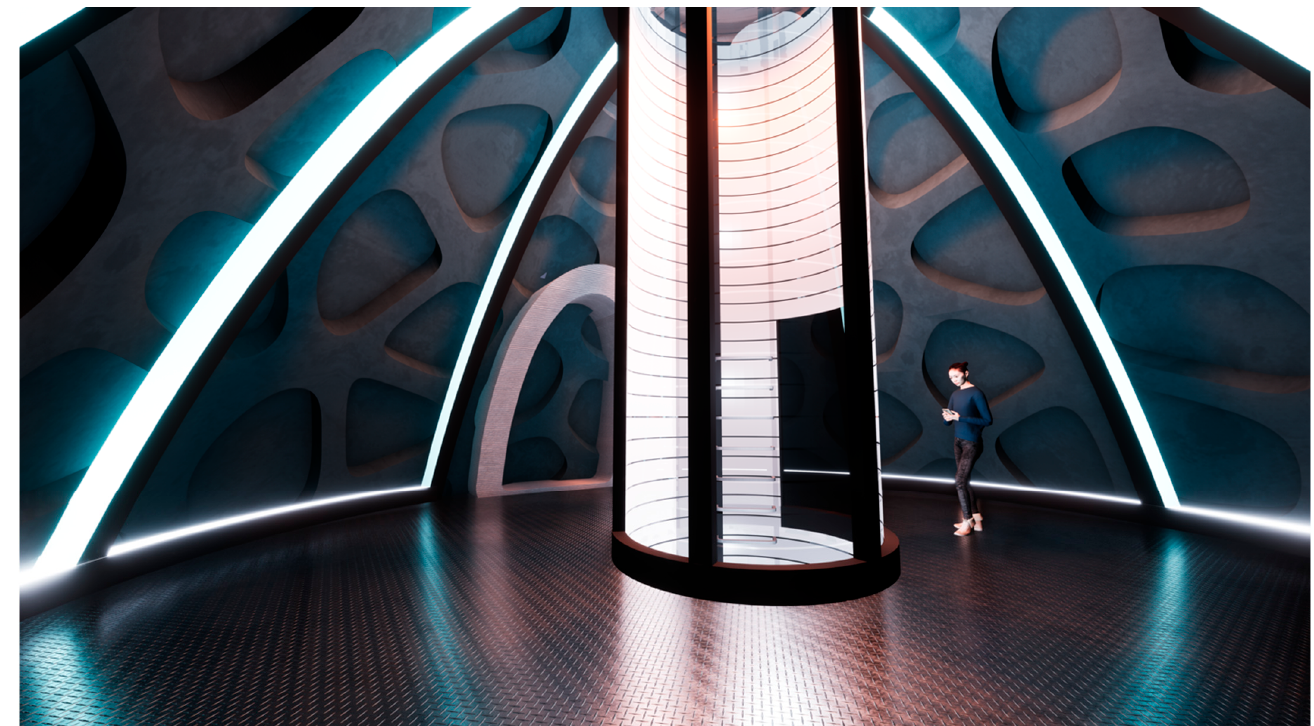
Figure 10. A view of a 3D section in the perspective of a semi-submerged habitat.